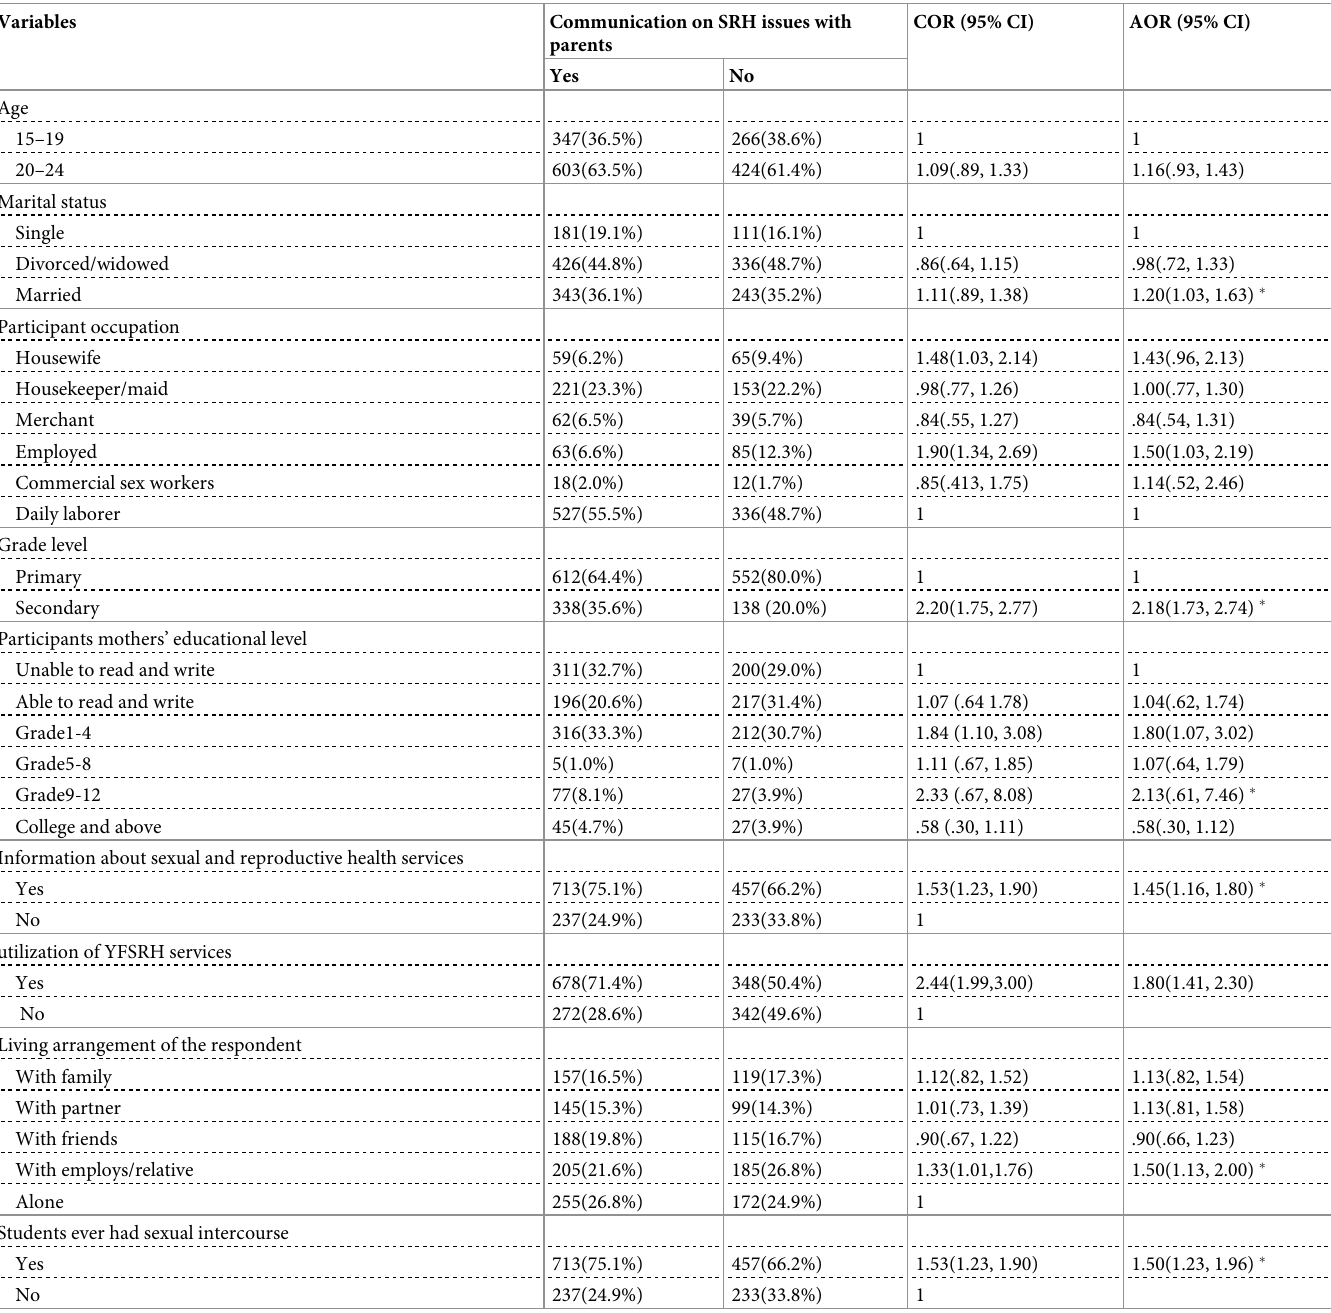
Table 4. Bivariate and multivariable logistic regressions on factors associated with youth-parent y\communications on SRH issues in the last 6 months in Amhara Region, Ethiopia, 2018.